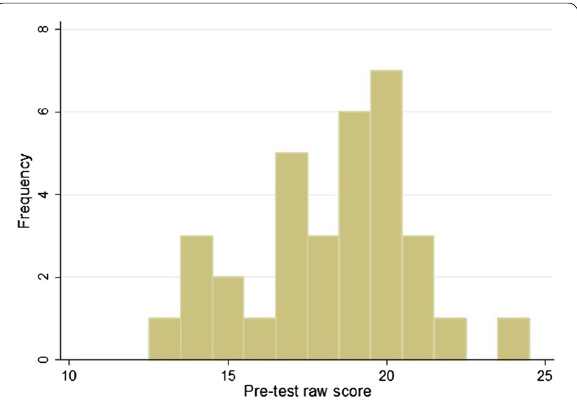
Fig. 2 Distribution of pre-test raw scores (of a possible 30 points),